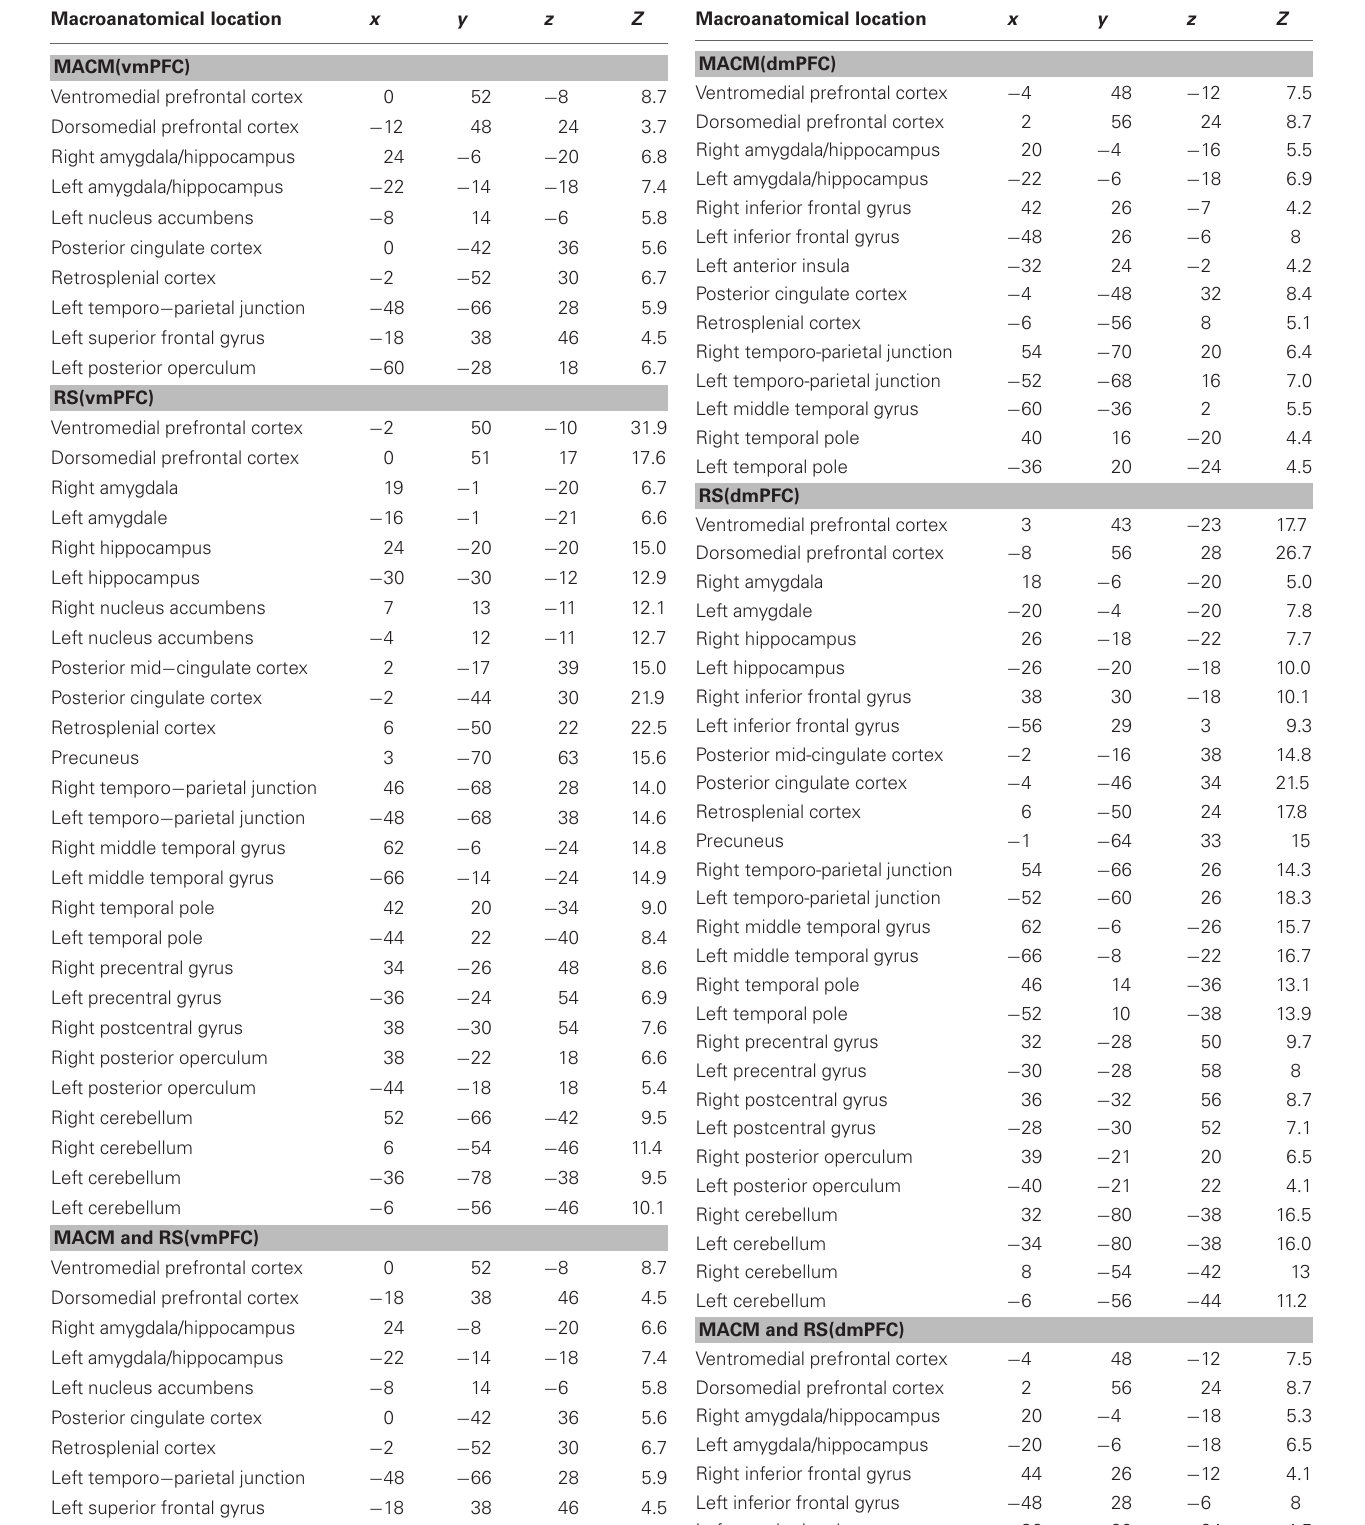
Table 1 | Functional connectivity of the vmPFC seed. Table 2 | Functional connectivity of the dmPFC